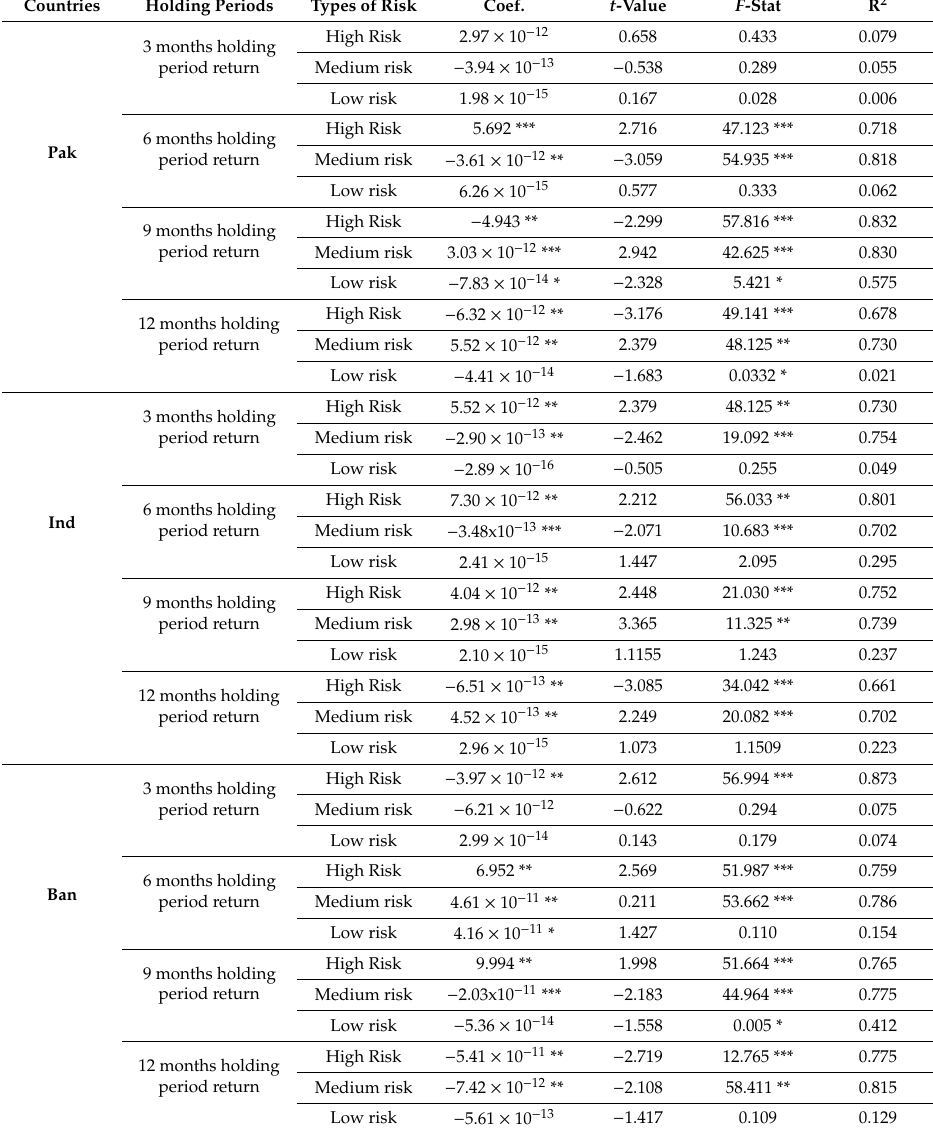
Table 5. Hypotheses testing W.R.T. momentum